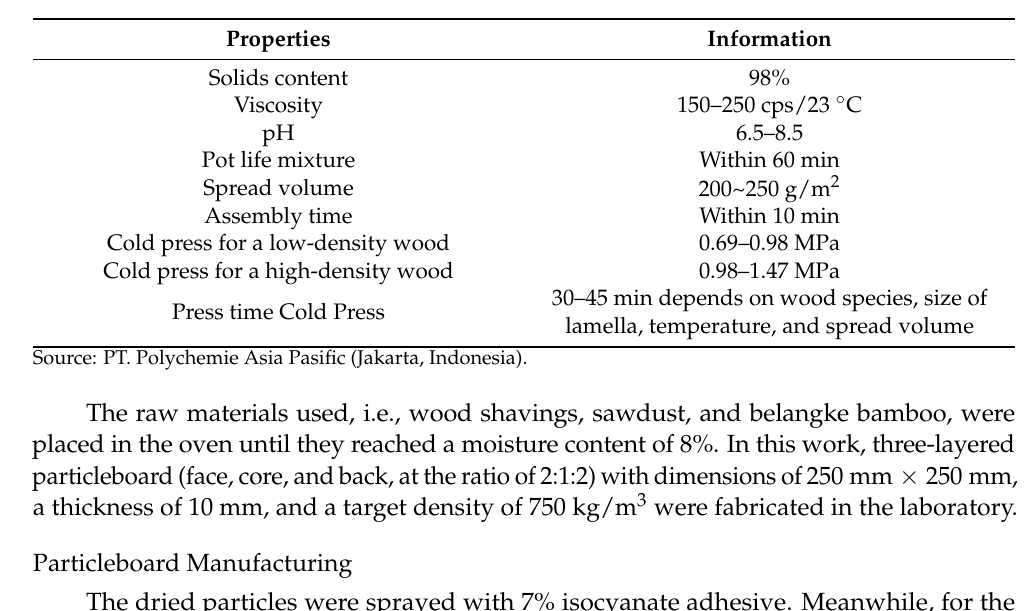
Table 2. Properties of isocyanate adhesive used in this